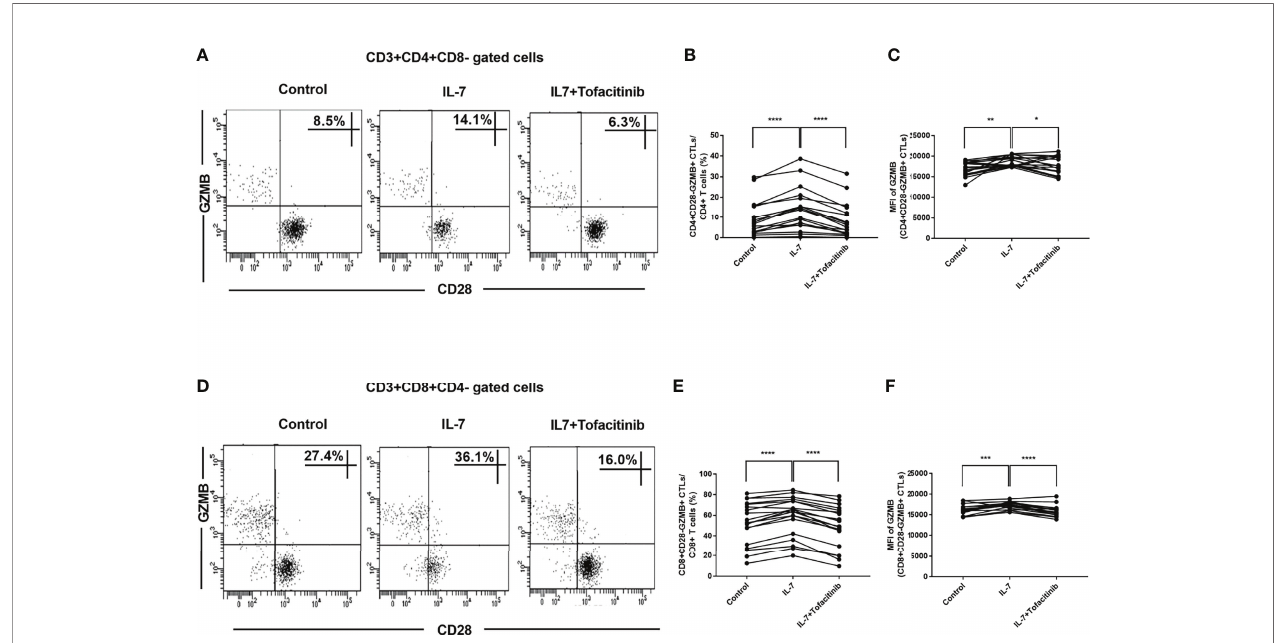
FIGURE 6 | The effects of IL-7 on the proportions of CD28-GZMB+ CTLs and the expression of GZMB in IgG4-RD patients. PBMCs from IgG4-RD patients (n = 19) were stimulated with 50 ng/mL IL-7 in the presence or absence of 150 nM tofacitinib for 4 days. (A, D) Representative dot plots of fl ow cytometry analysis. CD4+CD28-GZMB+ and CD8+CD28-GZMB+ CTL percentages in CD4 and CD8 T cells were shown. (B, E) The percentages of CD4+CD28-GZMB+ CTLs and CD8+CD28-GZMB+ CTLs in IgG4-RD patients were compared between IL-7-treated and untreated samples, and between IL-7-treated and IL-7 plus tofacitinib samples as well. The paired two-tailed Student ’ s t-test was used to compare two groups. **** P < 0.0001. (C, F) MFI of GZMB in CD4+CD28- CTLs and CD8+CD28- CTLs from IgG4-RD patients were compared between IL-7-treated and untreated samples, and between IL-7-treated and IL-7 plus tofacitinib samples as well. The paired two-tailed Student ’ s t-test was used to compare two groups. * P < 0.05; ** P < 0.01; *** P < 0.001; **** P <